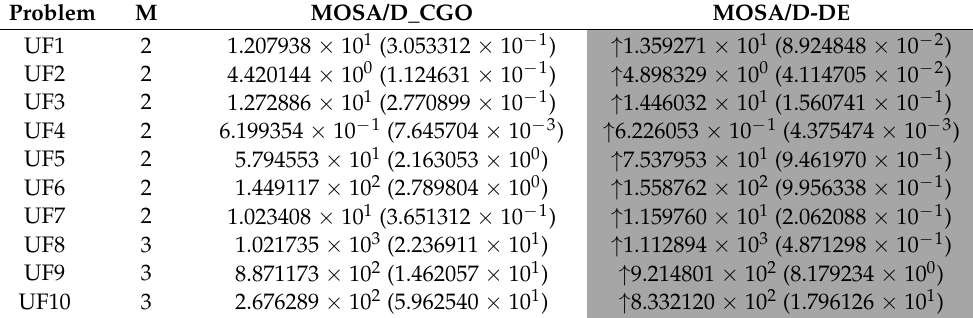
Table 7. Means and standard deviation of HV results of 20 instances.